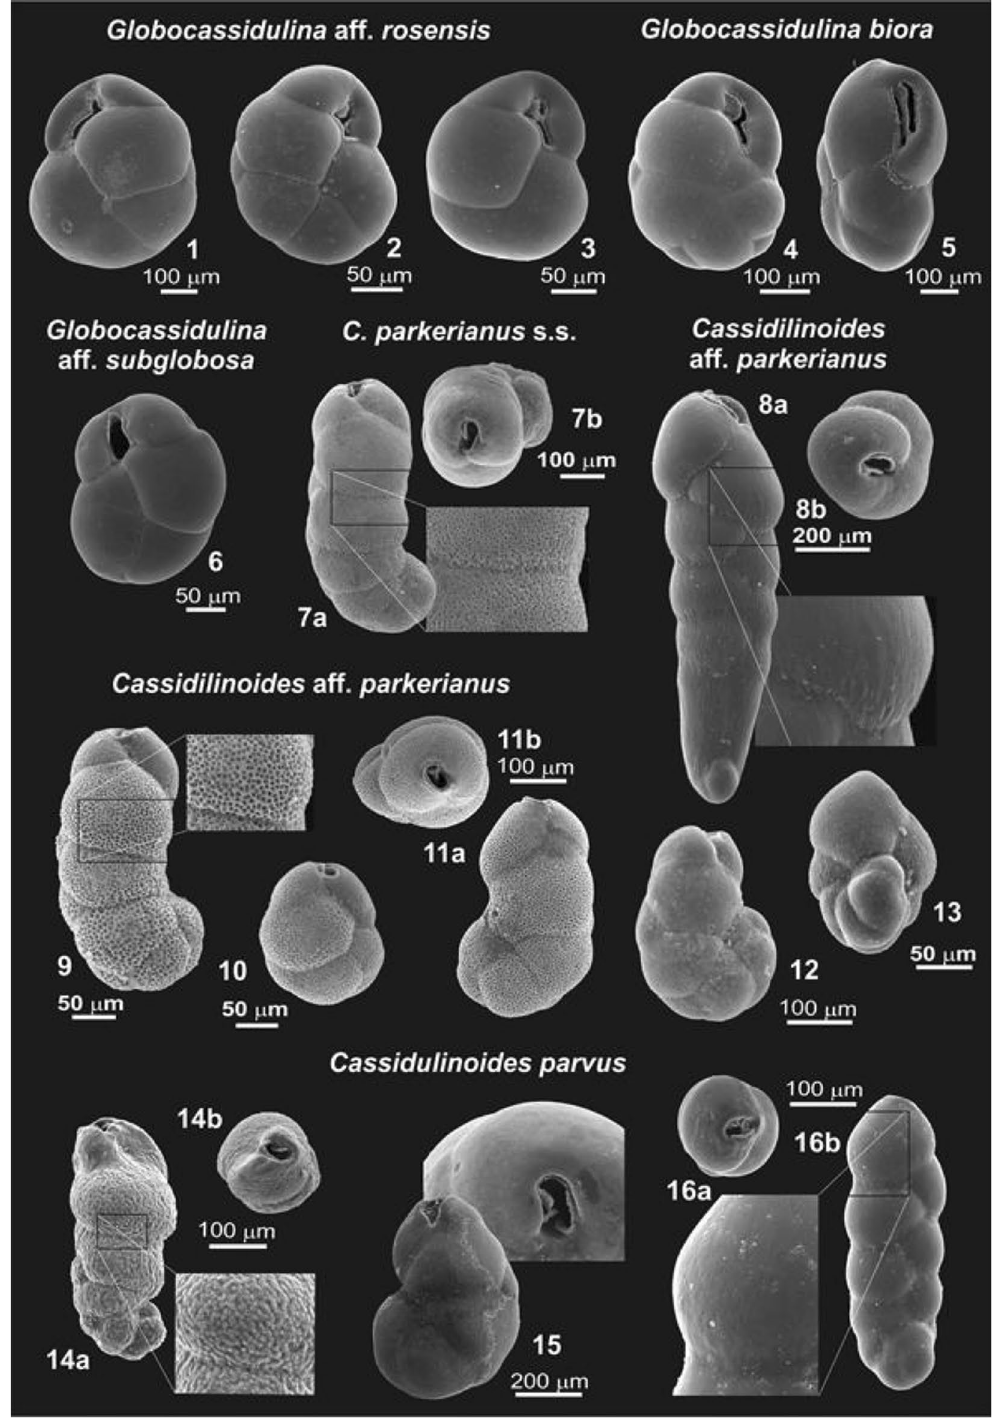
Figure 3. SEM images of Cassidulinidae from the Drake Passage and the Scotia Sea sector of South Atlantic, including West Antarctica: ( 1 – 3 ) Globocassidulina aff. rossensis from southern Patagonia, the Falklands, and South Georgia; ( 4–5 ) Globocassidulina biora from South Shetlands, immature form with bifurcated aperture and mature one with doubled aperture; ( 6 ) Globocassidulina aff. subglobosa from the Ross Sea; ( 7 ) Cassidulinoides parkerianus s.s. from southern Patagonia; ( 8 , 13 ) Cassidulinoides aff. parkerianus , the smoothly-walled conical morphotype from South Georgia; ( 9–12 ) Cassidulinoides aff. parkerianus , the porous morphotype from South Georgia (two specimenes), South Shetlands, and the Falklands; ( 14–16 ) Cassidulinides parvus , granular morphotype from South Shetlands, megalospheric and microsphelic variants of the smoothly-walled tubular morphotype from the Ross Sea. For more images showing full morphological diversity, see Appendix